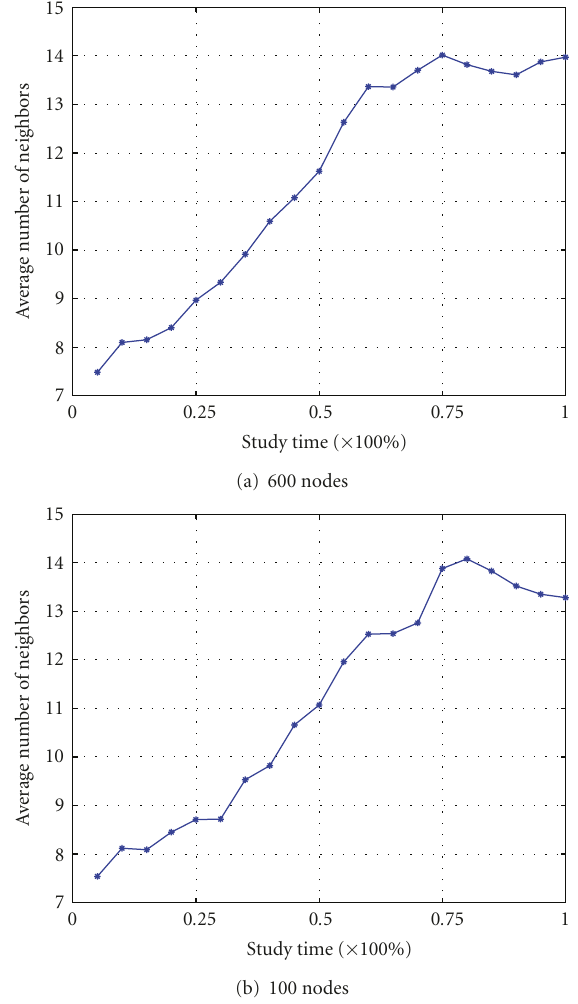
Figure 4: Average number of neighbors versus study time when using the small data